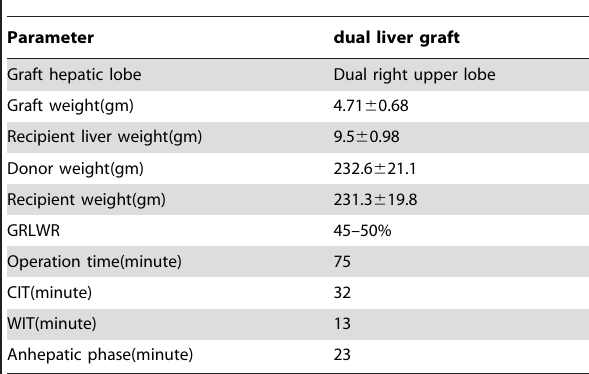
Table 3. Graft, donor and recipient data.